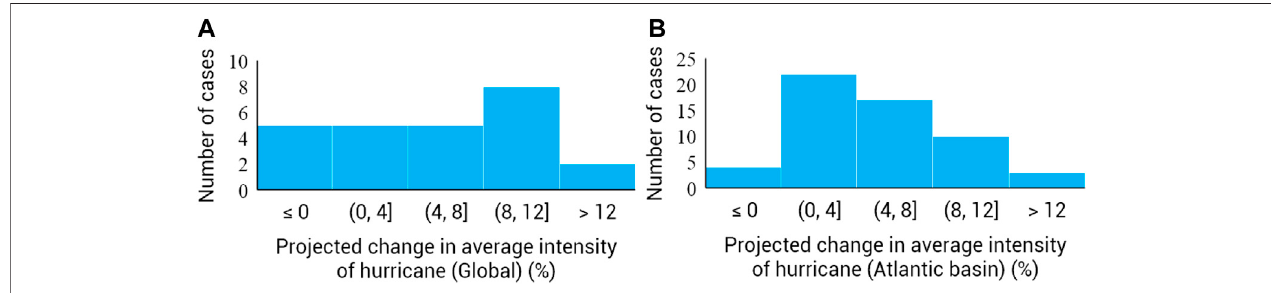
FIGURE 1 | Histograms of projected changes of average hurricane intensity in different studies (Knutson et al., 2019): (A) global; (B) Atlantic